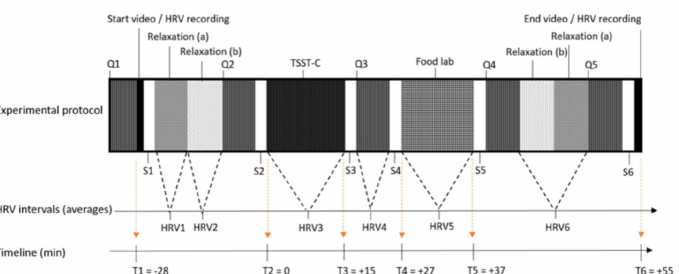
Figure 1. Experimental design of the study. Experimental design including the main parts and timeline: time in min relative to the Trier Social Stress Test for Children (TSST-C) (T1-T6), questionnaires (Q1-Q5), saliva collections (S1-S6), and heart rate variability measurement intervals (HRV1-HRV6).